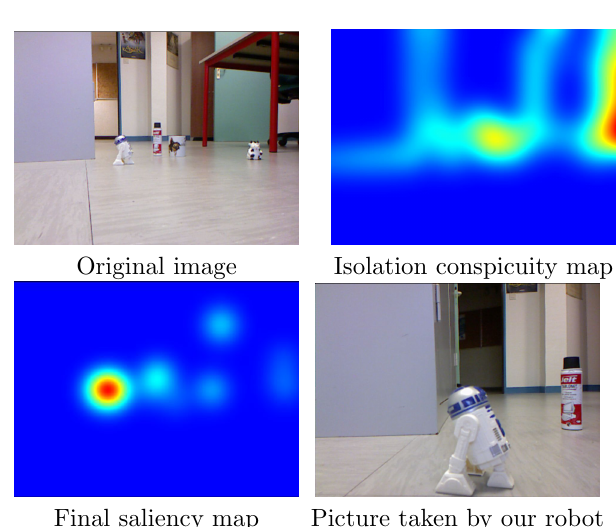
Figure 9. Presentation of different elements of Curious-